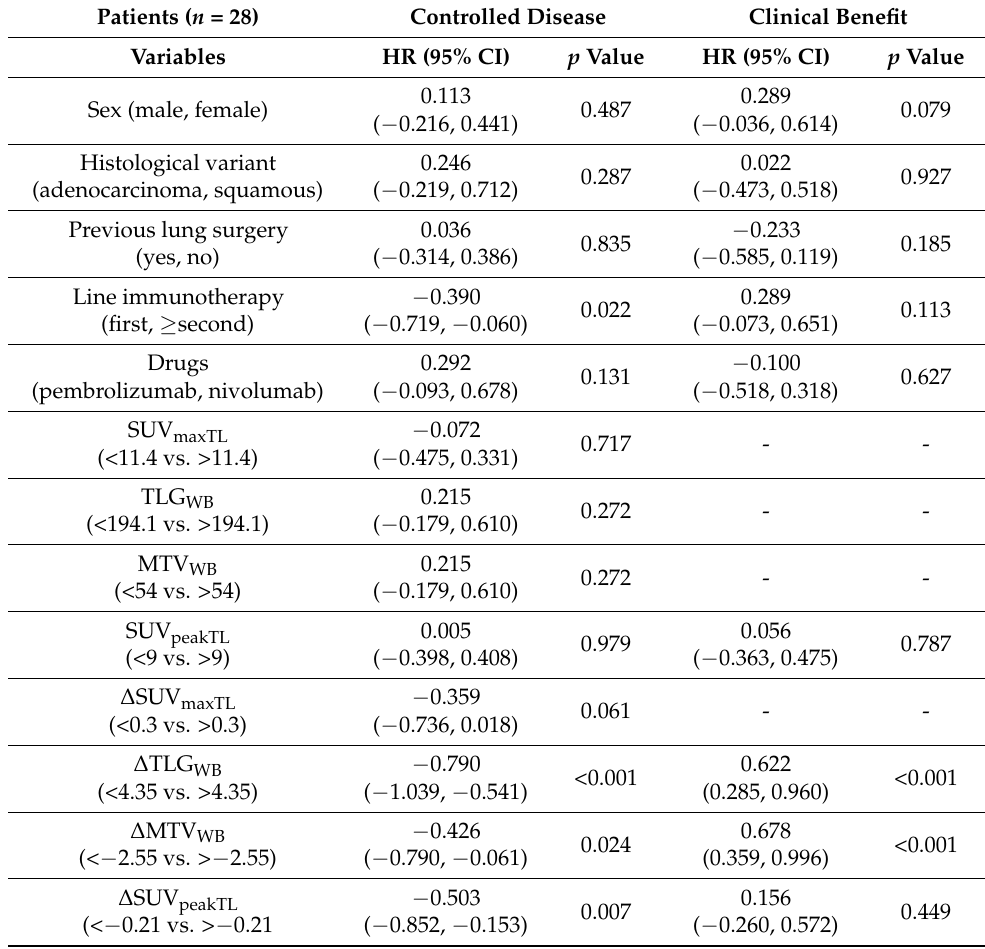
Table 4. Predictive role of patients’ clinical pathological features and PET-derived parameters in multivariate